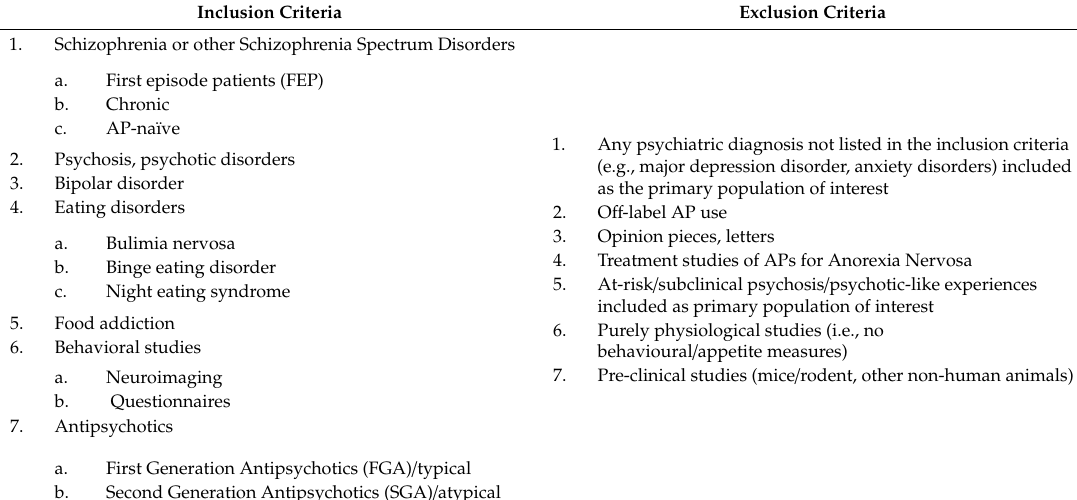
Table 1. List of inclusion and exclusion criteria for selected